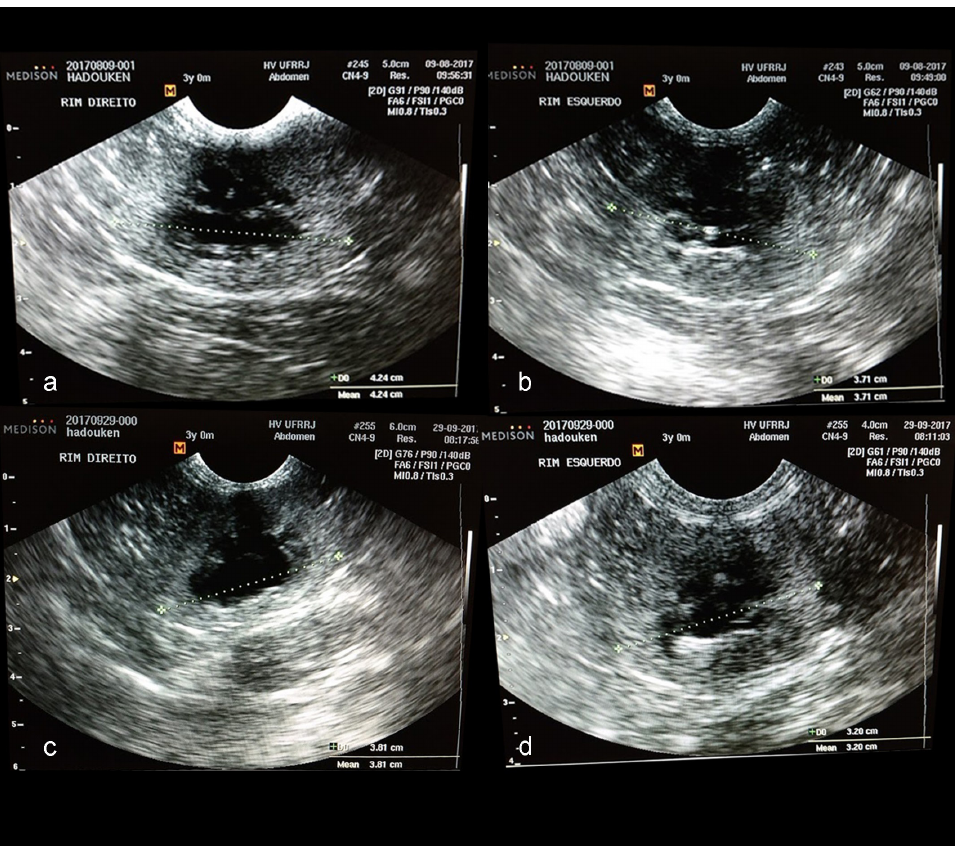
Figura 2. Imagem ultrassonográfica para acompanhamento antes e após o tratamento revelando diminuição no tamanho renal. (a) Rim direito antes do tratamento medindo em seu maior diamêtro 4,24 cm; (b) Rim esquerdo antes do tratamento medindo em seu maior diamêtro 3,71 cm; (c) Rim direito após o tratamento medindo em seu maior diamêtro 3,81 cm; (d) Rim esquerdo após o tratamento medindo em seu maior diamêtro 3,20 cm.